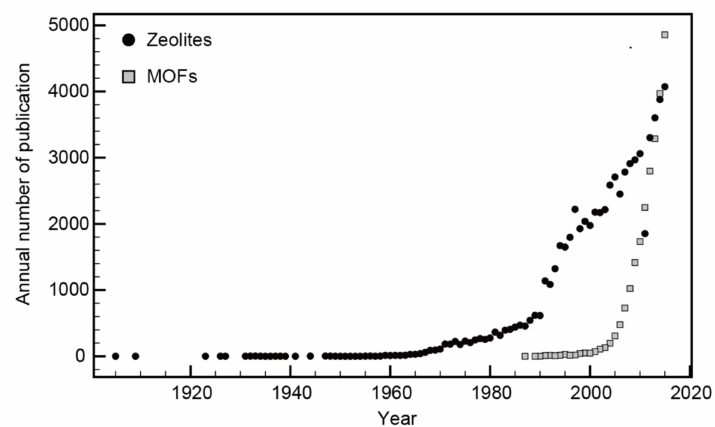
Figure 1. Number of publications on zeolites (black circles) and MOFs (gray squares) in given year.